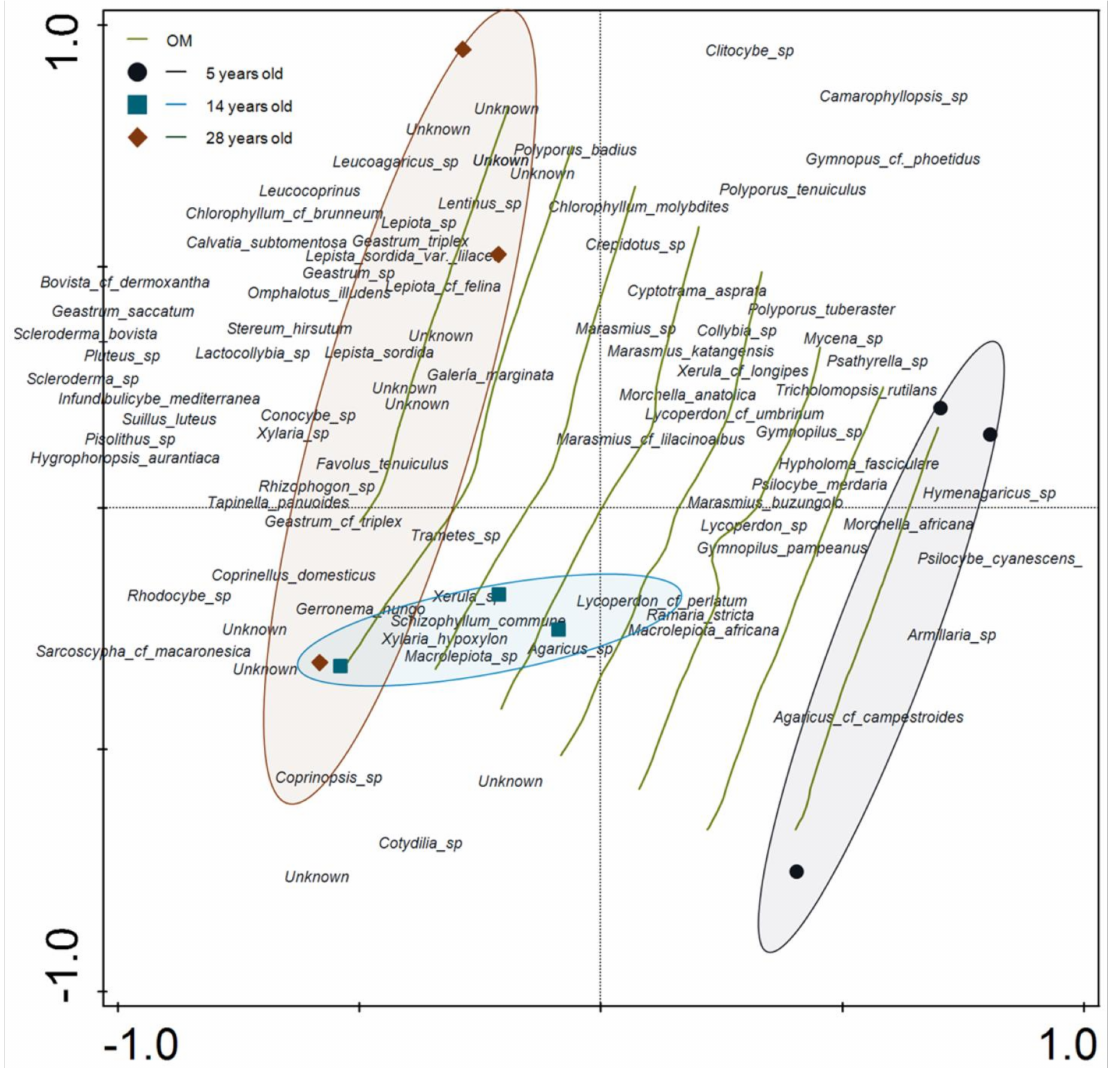
Figure 4. Non-metric multidimensional scaling (NMDS) ordination graph based on dissimilarities calculated using the Bray–Curtis index of macrofungal taxa composition of young (5 years old), medium-aged (14 years old), and mature (28 years old) Pinus radiata stands in Menagesha Suba, central Showa, Oromia National Regional State, Ethiopia. The ellipsoids visually cluster stands belonging to the same age group, while the isolines represent the organic matter (OM) values (fitted Loess model R 2 = 0.86).